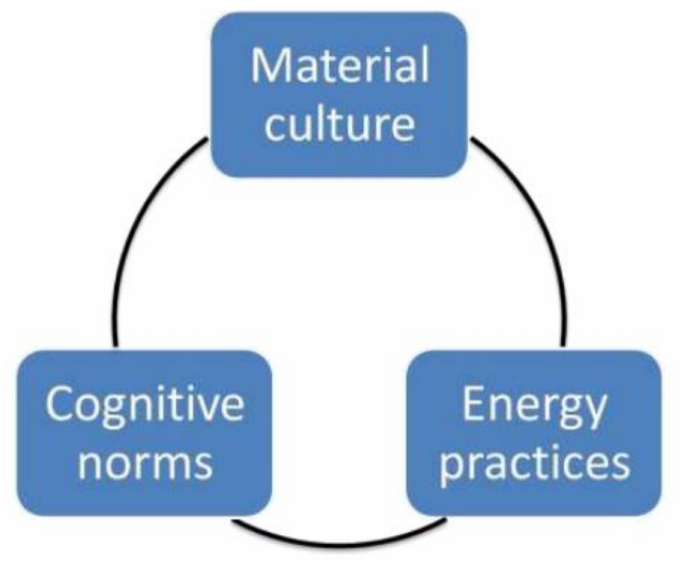
Figure 4. Energy and cultural system